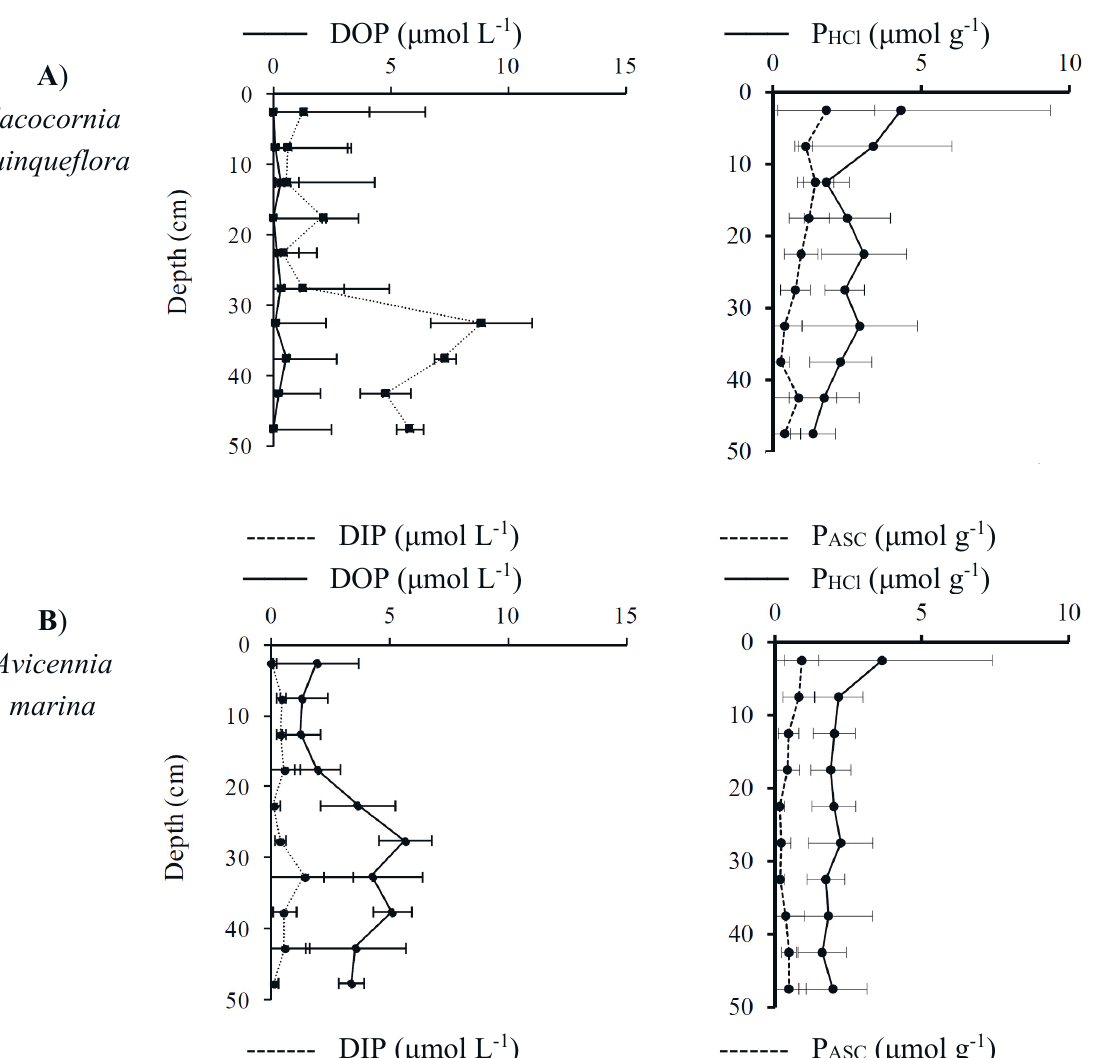
Figure 6. Mean concentrations ( n = 3) and standard deviation of dissolved organic nitrogen (DON), nitrate + nitrite (NO X ) and NH 4+ in sediments of the three vegetation stands. Please note differences in y-axis scales for the NH 4+ and NO X between the three vegetation